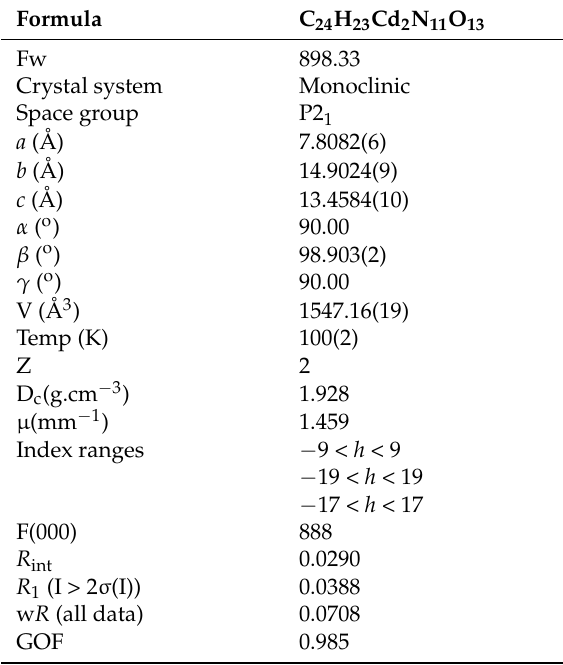
Table 1. Crystal data and structure refinement for compound 1